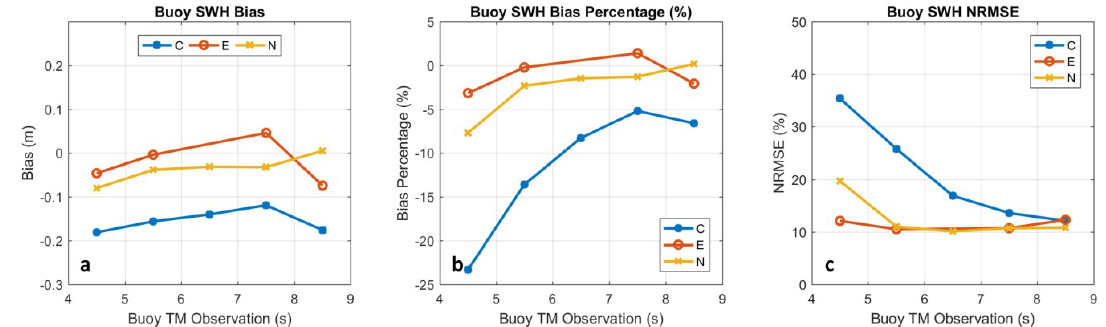
Figure 3. Validation of buoy SWH observations against Jason-3 SWH. ( a ) indicates the biases of the three buoy networks distributed with the mean wave period; ( b ) indicates the bias percentage distribution with the mean wave period; ( c ) indicates the NRMSE distribution with the mean wave period. The legends C, E and N represent the Chinese network, European network and NDBC,